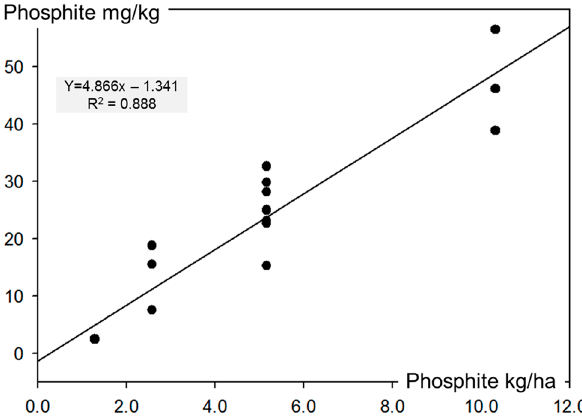
Figure 7. Correlation between the total amount of phosphite (PO 33 − ) applied with Phosfik ® ( x -axis) and the measured phosphite residues in potato tubers ( y -axis) from the field experiments in 2012 ( n = 6) and 2013 ( n = 12). Four samples with 1.29, seven with 5.16, four with 2.58 and three with 10.32 kg PO 33 − /ha, respectively.